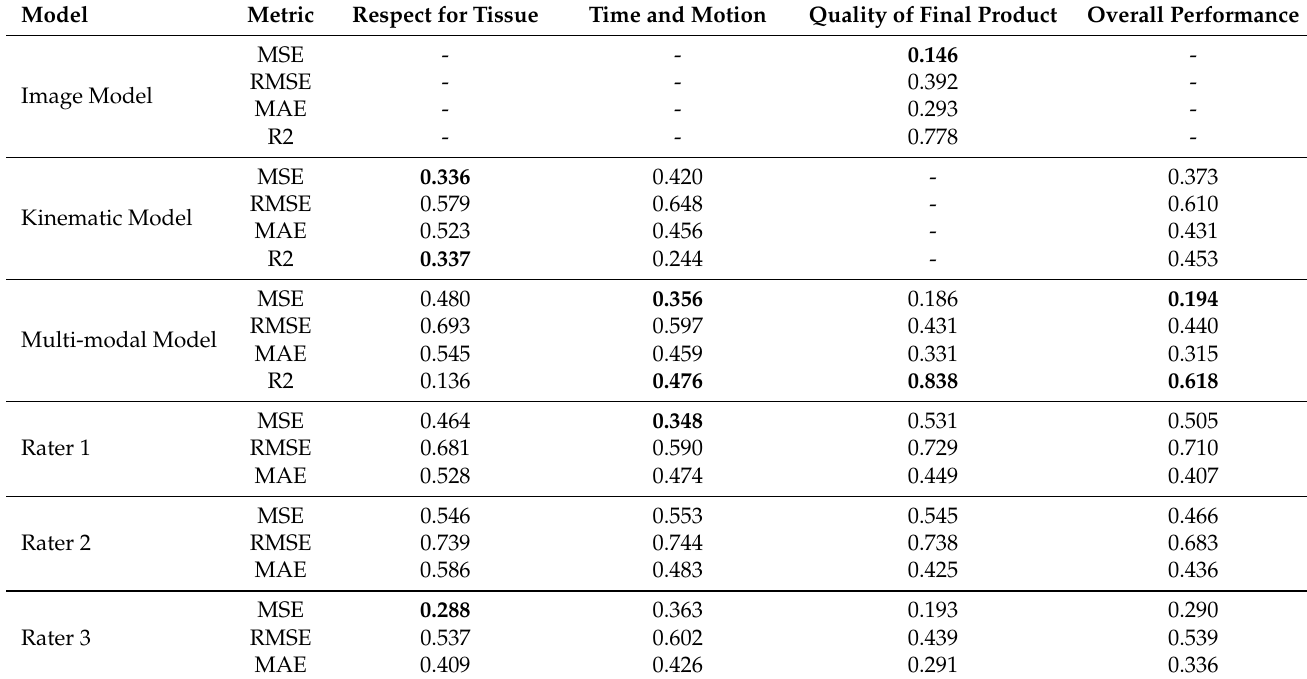
Table 6. Performance metrics, including mean squared Error (MSE), of the AI predictions and human ratings, compared to the ground truth (mean of human scores).